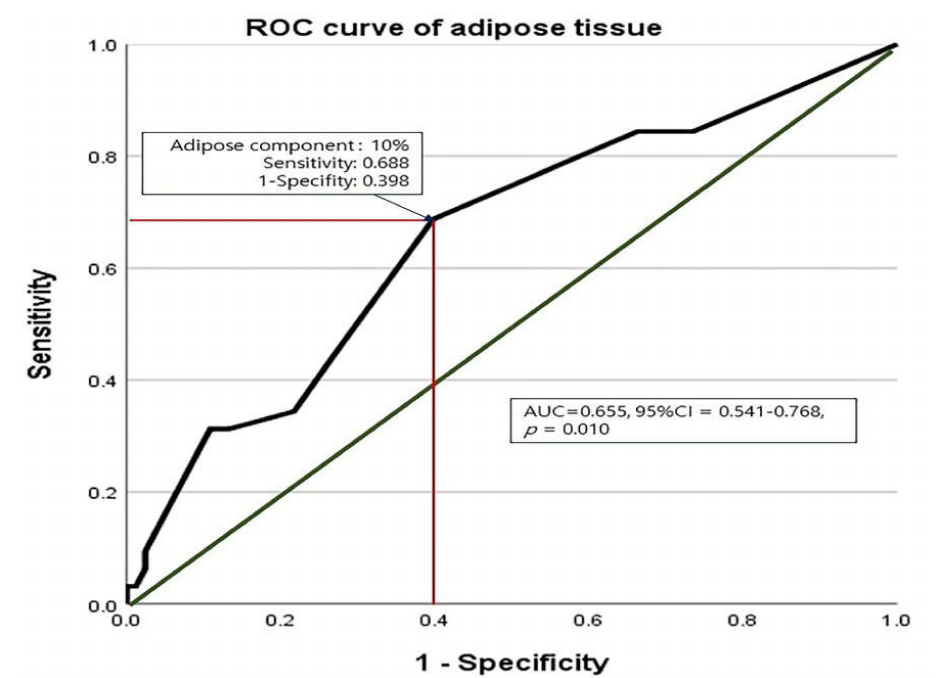
Figure 3. The receiver operating characteristic curve for the effect of left atrial adipose tissue on atrial fibrillation recurrence.